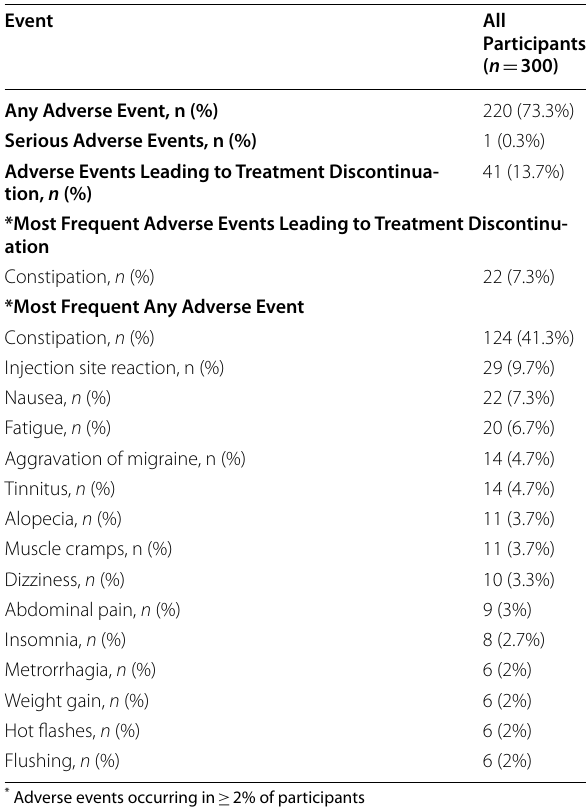
Table 2 Treatment‑emergent adverse